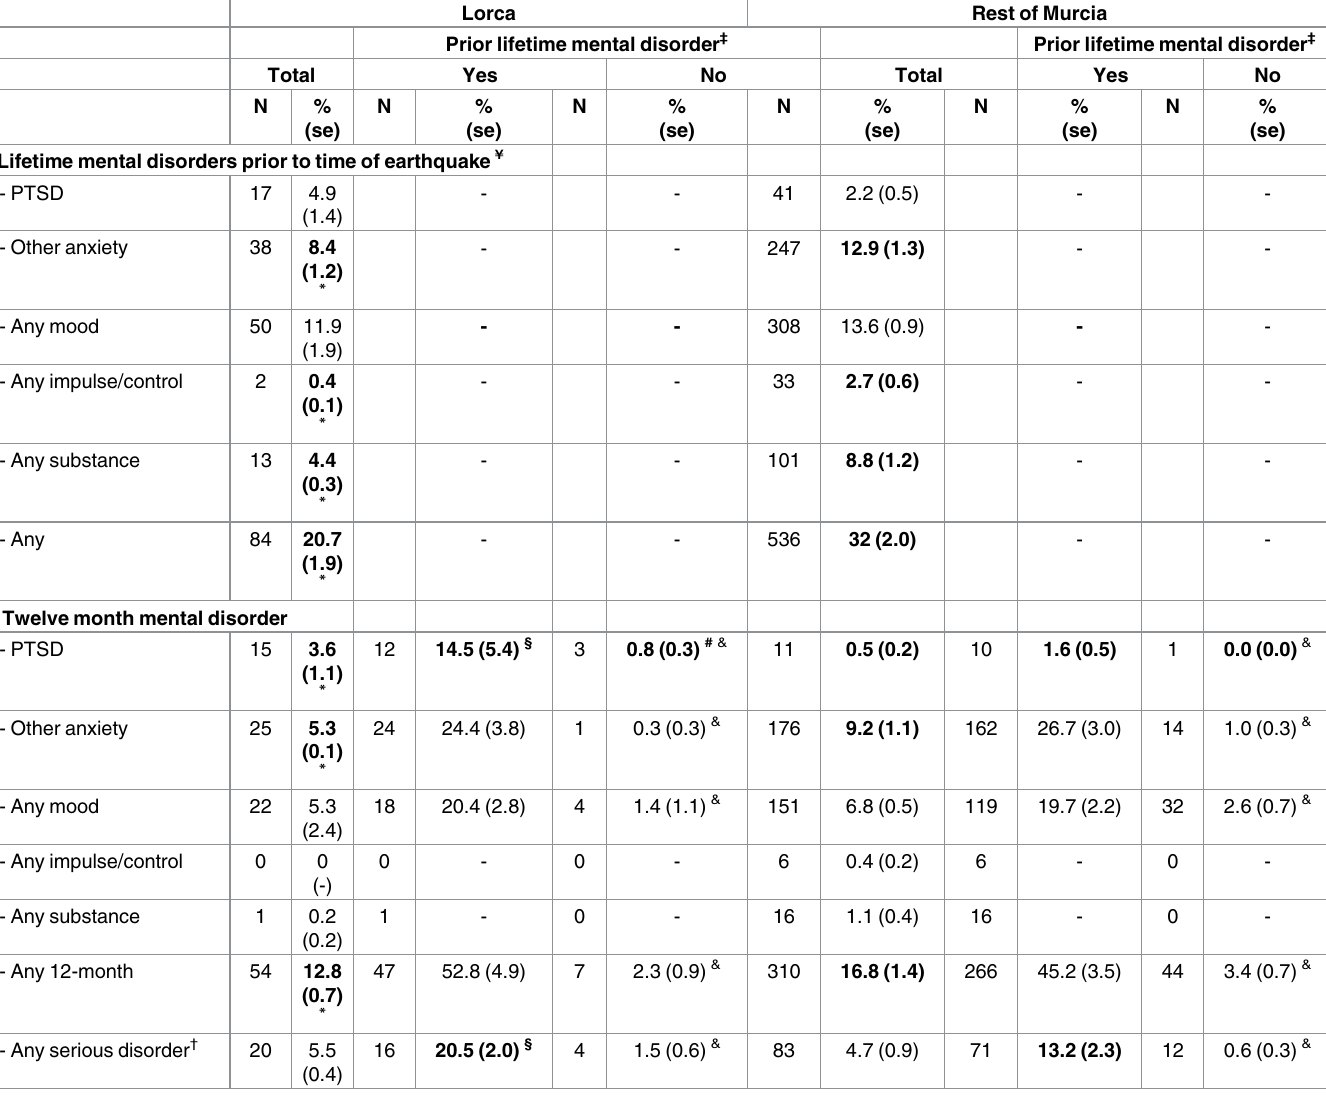
Table 3. Lifetime mental disorders prior to earthquakes and 12-month post-earthquake mental disorder prevalence in relation to prior lifetime mental disorders in Lorca versus the rest of